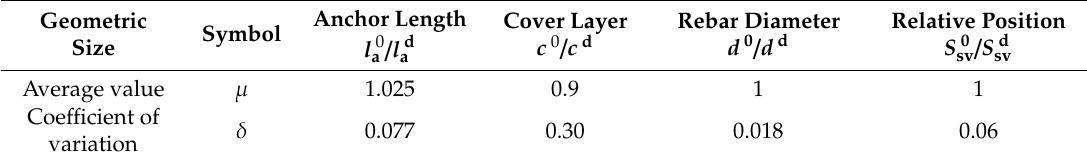
Table 6. Statistical parameters for the geometric dimensions of structural